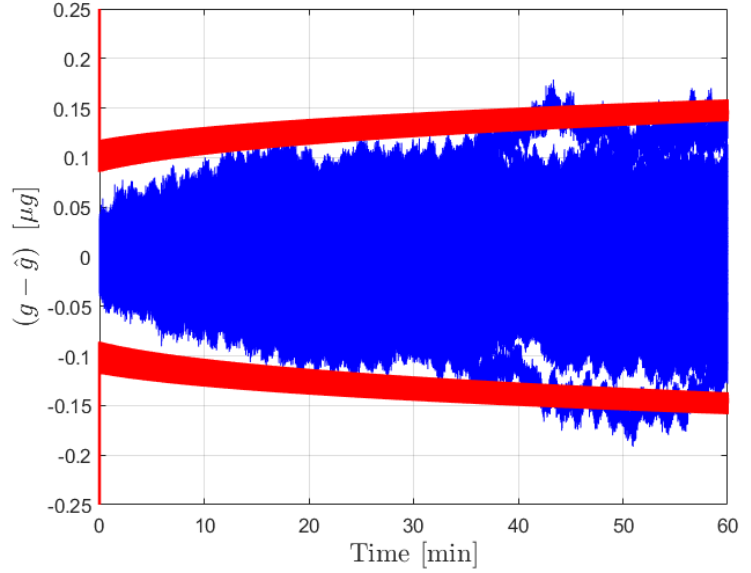
Figure 6. Results for the forcing acceleration estimate error from the Kalman filter procedure for 100 Monte Carlo iterations. Estimate error is plotted in blue with the associated 3 σ bounds in